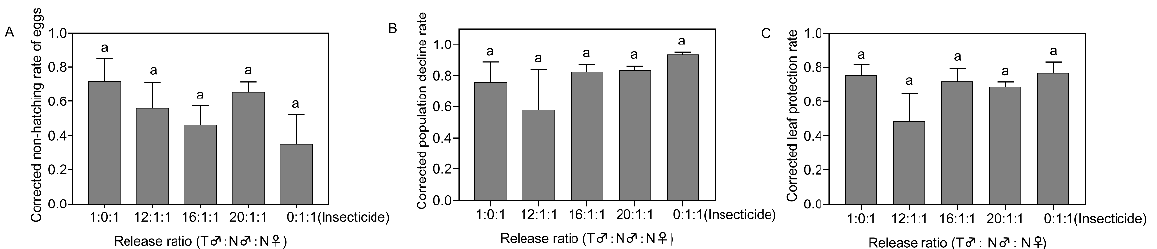
Figure 4. Corrected non-hatching rate of eggs ( A ), corrected population decline rate ( B ), and corrected leaf protection rate ( C ) after 21 days of field release of Spodoptera frugiperda in different proportions. Data in the figure are the mean ± standard error; different lowercase letters indicate significant differences (one-way ANOVA, Tukey’s HSD; p < 0.05); T = treated with irradiation; N = not irradiated; insecticide were sprayed on the third day after insect release.